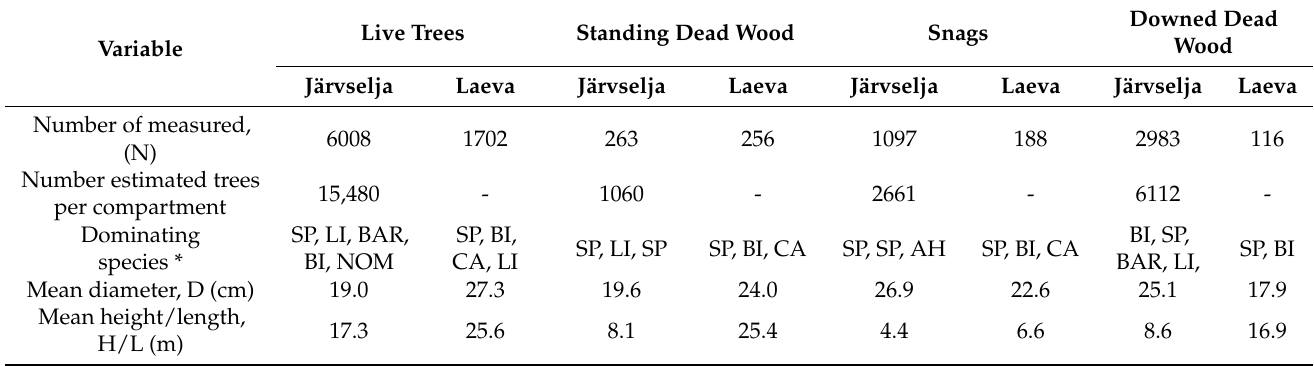
Table 1. Summary statistics of the measured